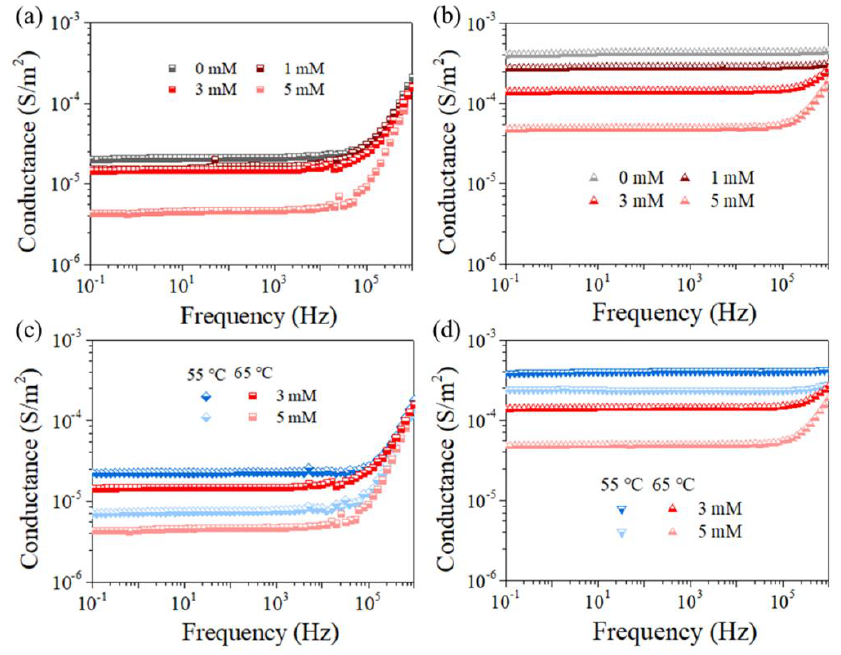
Figure A3. Conductance of PVDF ( a , c ) and PTFE ( b , d ) membrane versus MD duration for feeds with different PDS concentrations ( a , b ) and temperatures ( c , d ) according to Figures 4 and 5, respec- tively.